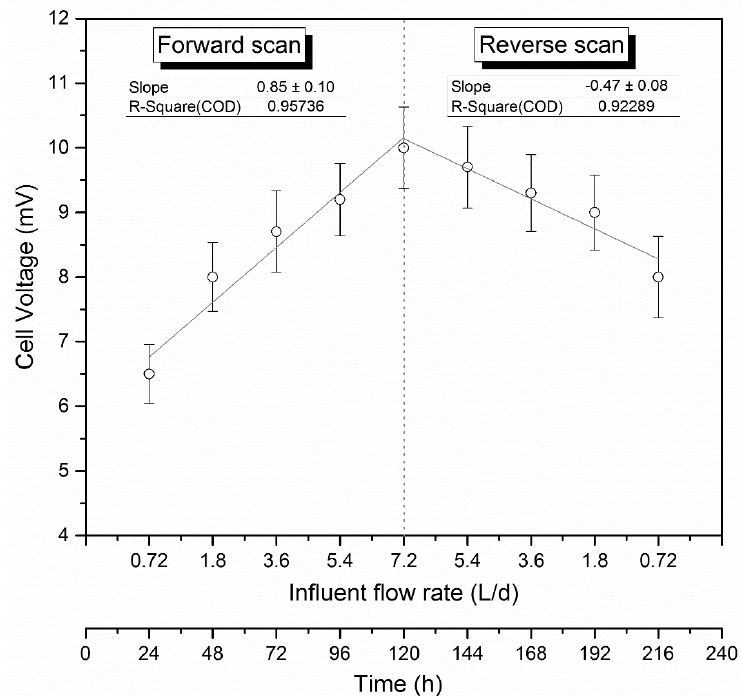
Figure 2. Effect of the influent flow rate on the steady-state exerted voltage. Figure 2. E ff ect of the influent flow rate on the steady-state exerted